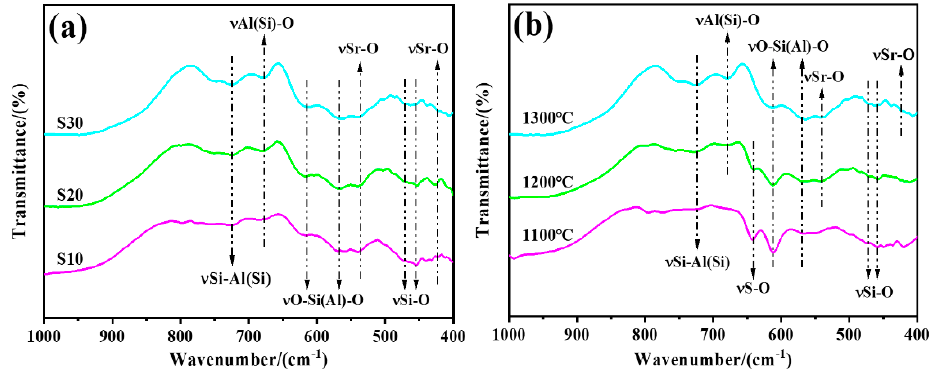
Figure 4. FT-IR spectra of the typical samples: ( a ) S0~S30 sintered at 1300 °C, and ( b ) S30 sintered at 1100–1300 °C.